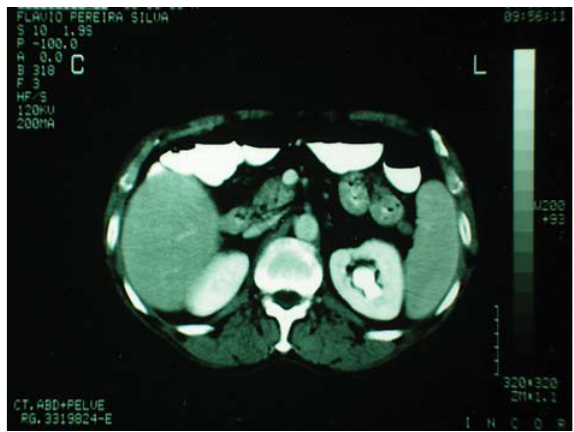
Figure 3 – Computed tomography showing calyceal dilatation in the left kidney.